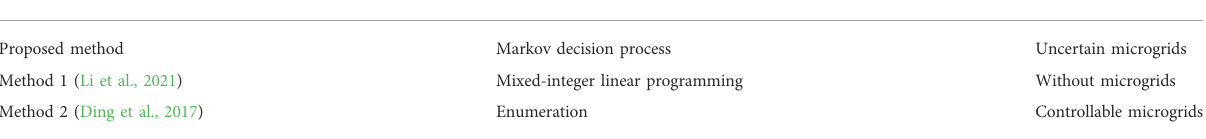
TABLE 4 Differences between different load restoration methods.